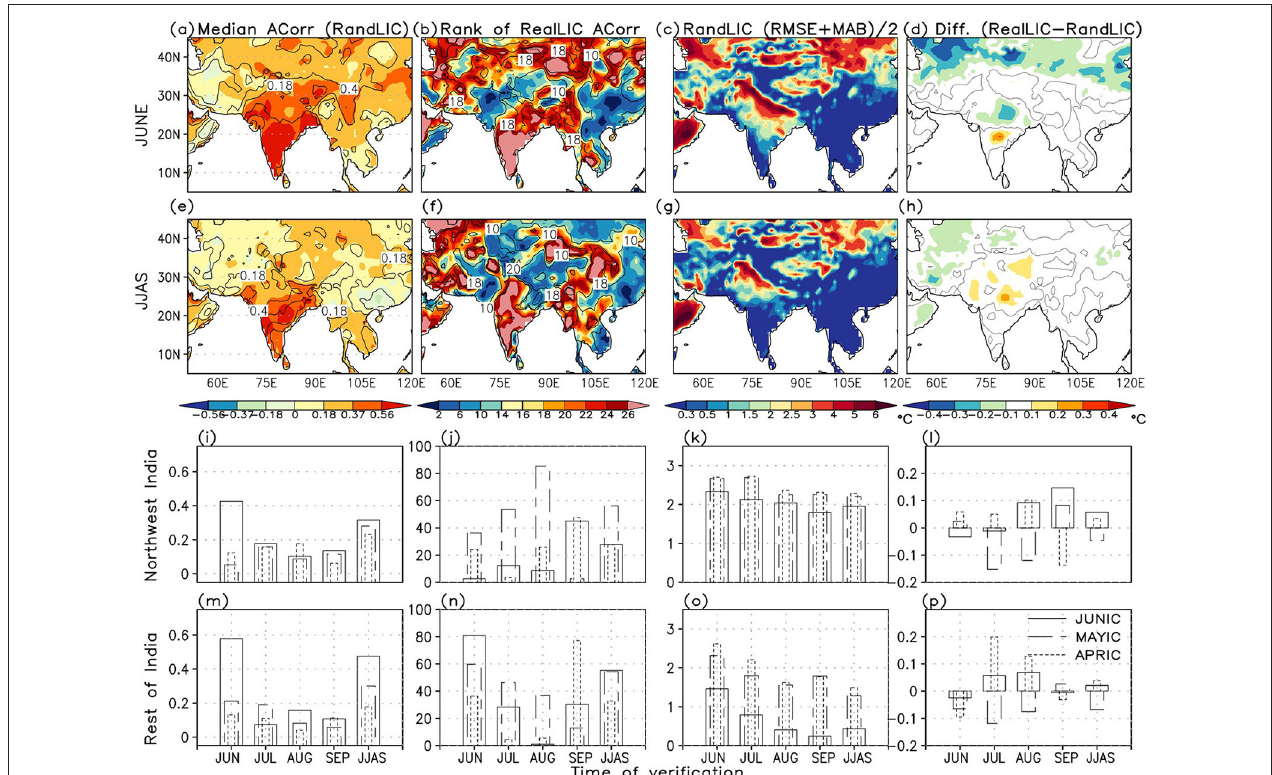
FIGURE 11 | (a) median anomaly correlation of 2m air temperature in June based on CFSv2 JUNIC hindcasts with RandLIC and CRU (shaded) and IMD (black contours). (b) rank of the anomaly correlation based on JUNIC hindcast with RealLIC among 28 ensemble members. (c) average of RMSE and MAB based on JUNIC hindcasts with RandLIC. (d) shows the difference of mean RMSE and MAB (RealLIC-RandLIC). (e–h) depict the same as in first row except for JJAS. (i,k,l,m,o,p) show the same for APRIC, MAYIC, and JUNIC hindcasts; except for each month in JJAS and area averaged for the northwest and rest of India domains, respectively. (j,n) depict the percentage area that shows RealLIC anomaly correlations in the upper quartile of the 28 ensemble members.